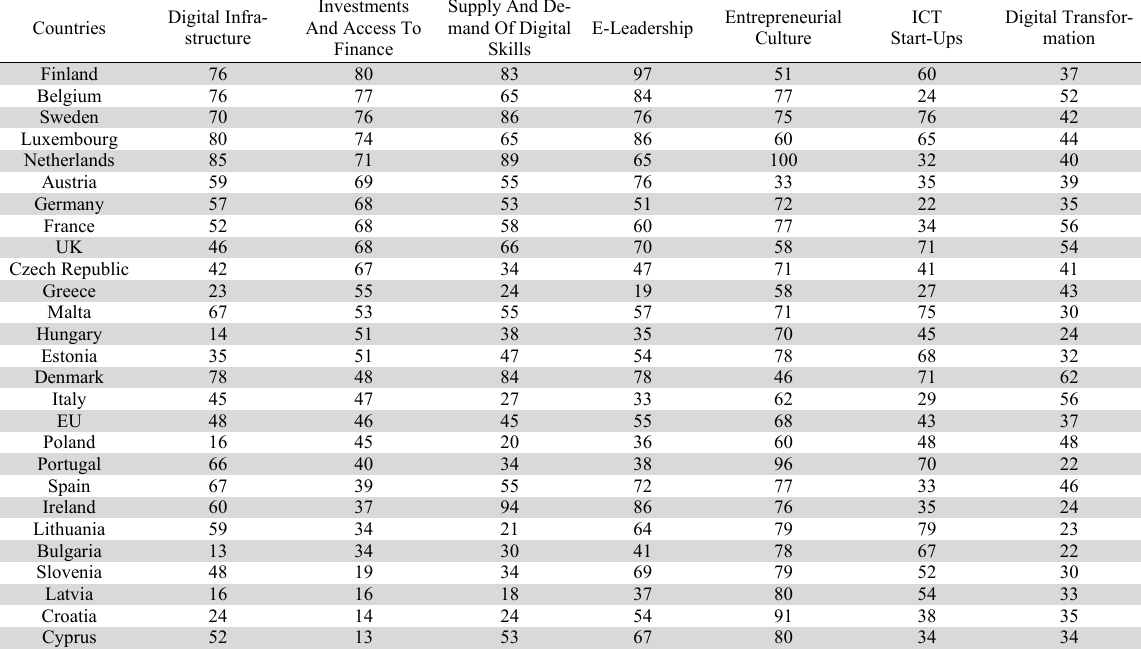
Index Scores of Digital Transformation Framework Digital Infra- Countries